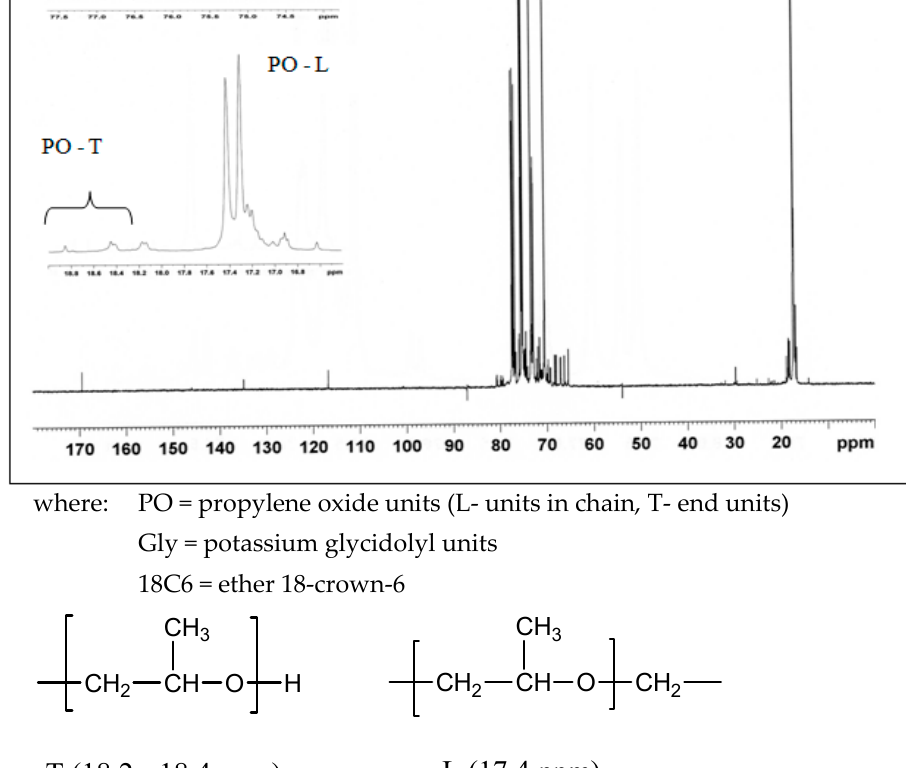
Figure 2. 1H I 13C NMR spectra of obtained star-shaped macroinitiator with 6 arms in the presence of crown ether 18-c-6.